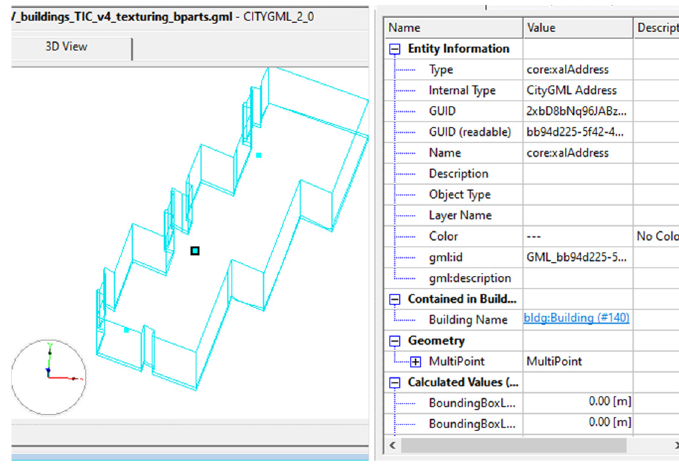
Figure 6. One of three address points within the same building.